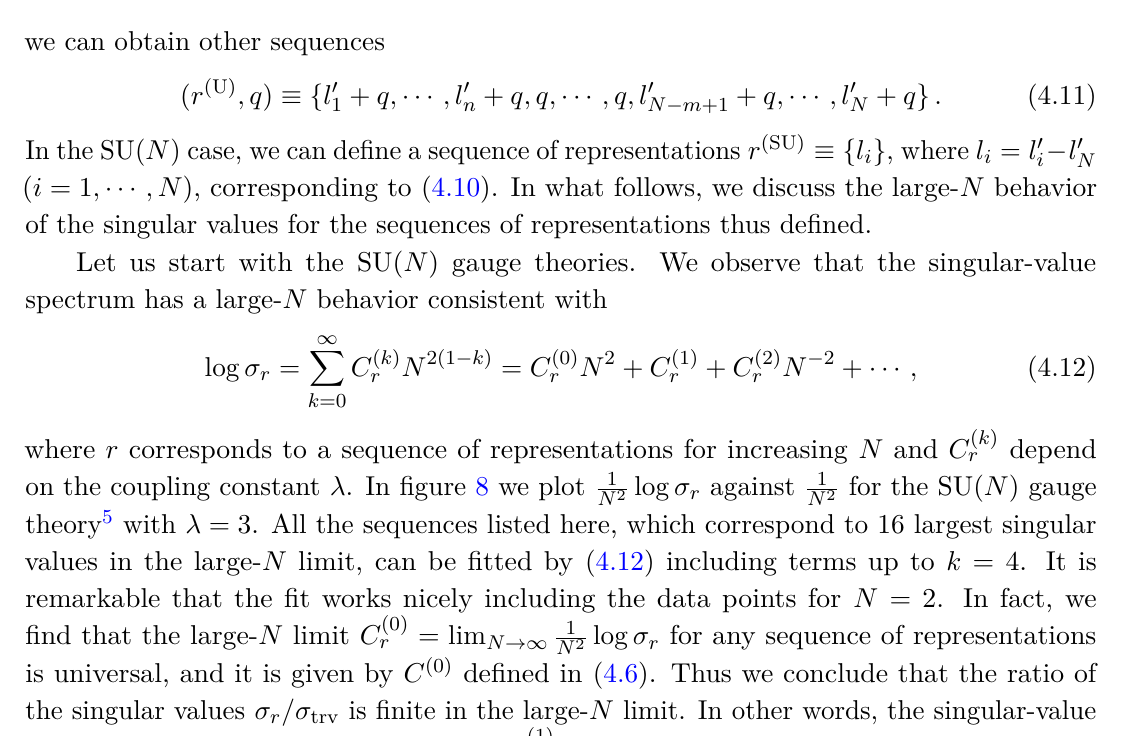
Figure 8 . The singular values 1 log σ r are plotted against 1 /N 2 for the SU ( N ) gauge theory N 2 with λ = 3 . Different symbols correspond to different sequences of representations as shown on the right of the plot. Each point is actually doubly degenerate except for real representations since representations that are complex conjugate to each other give identical singular values. We restrict ourselves to the sequence of representations that correspond to the 16 largest singular values in the large- N limit. The dashed lines represent fits to a quartic polynomial in 1 /N 2 for each sequence using N ≥ 2 , which turn out to merge at C (0) = 1 in the large- N 9